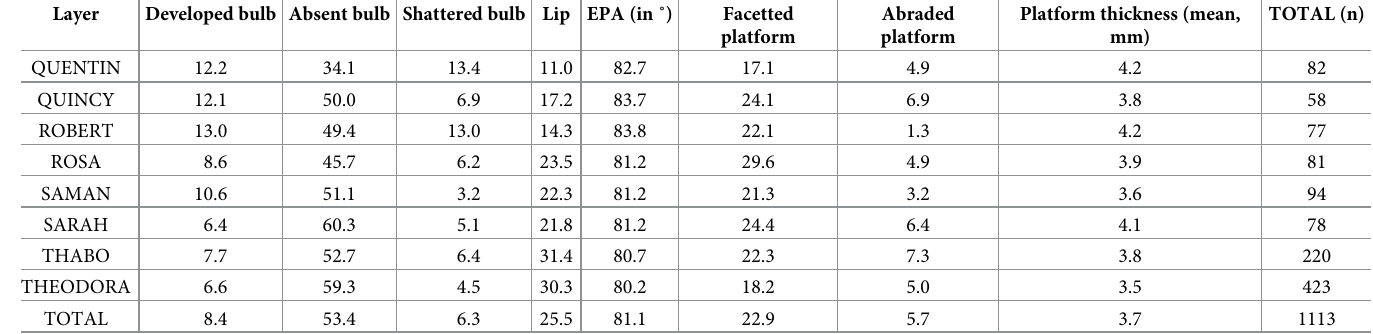
Table 6. Attributes assessed to reconstruct knapping technique and platform treatment for complete and proximal blades (in % until otherwise noted) by layer for the Sibudu HP.